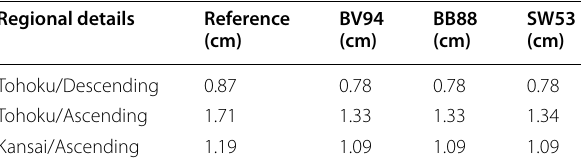
Table 3 Mean standard deviation of interferograms, before and